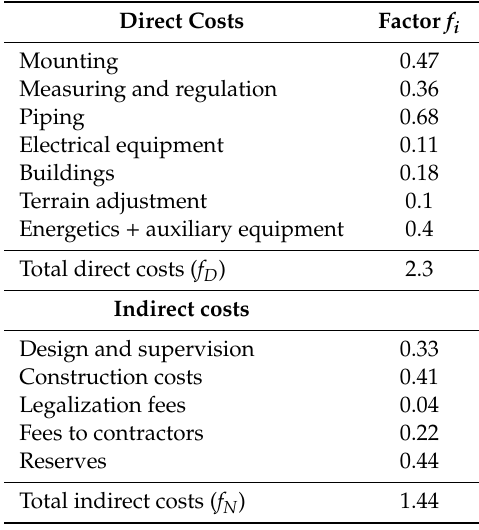
Table 8. Baumann factors for direct and indirect capital costs estimation